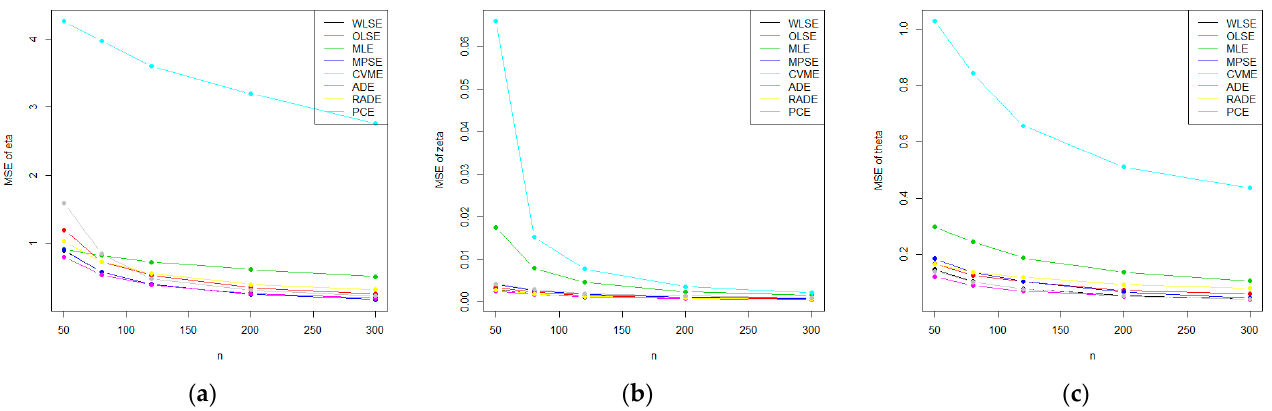
Figure 4. Plots of the mean square errors (MSE) of the E-NPF parameters for the eight methods of estimation using the values in Table 5 ( a – c ).